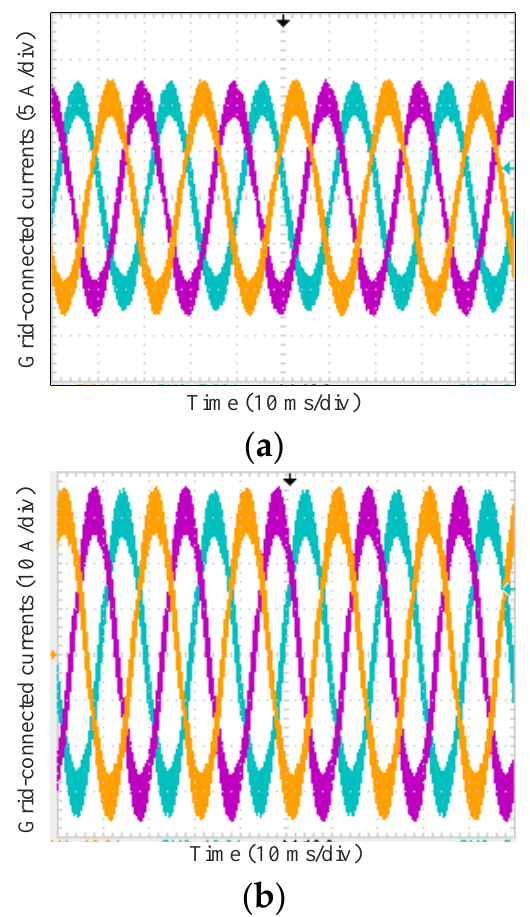
Figure 21. Current waveform of a VSG injected harmonic voltage in a weak grid. ( a ) Current waveform of a single VSG. ( b ) Current waveform of three VSGs.